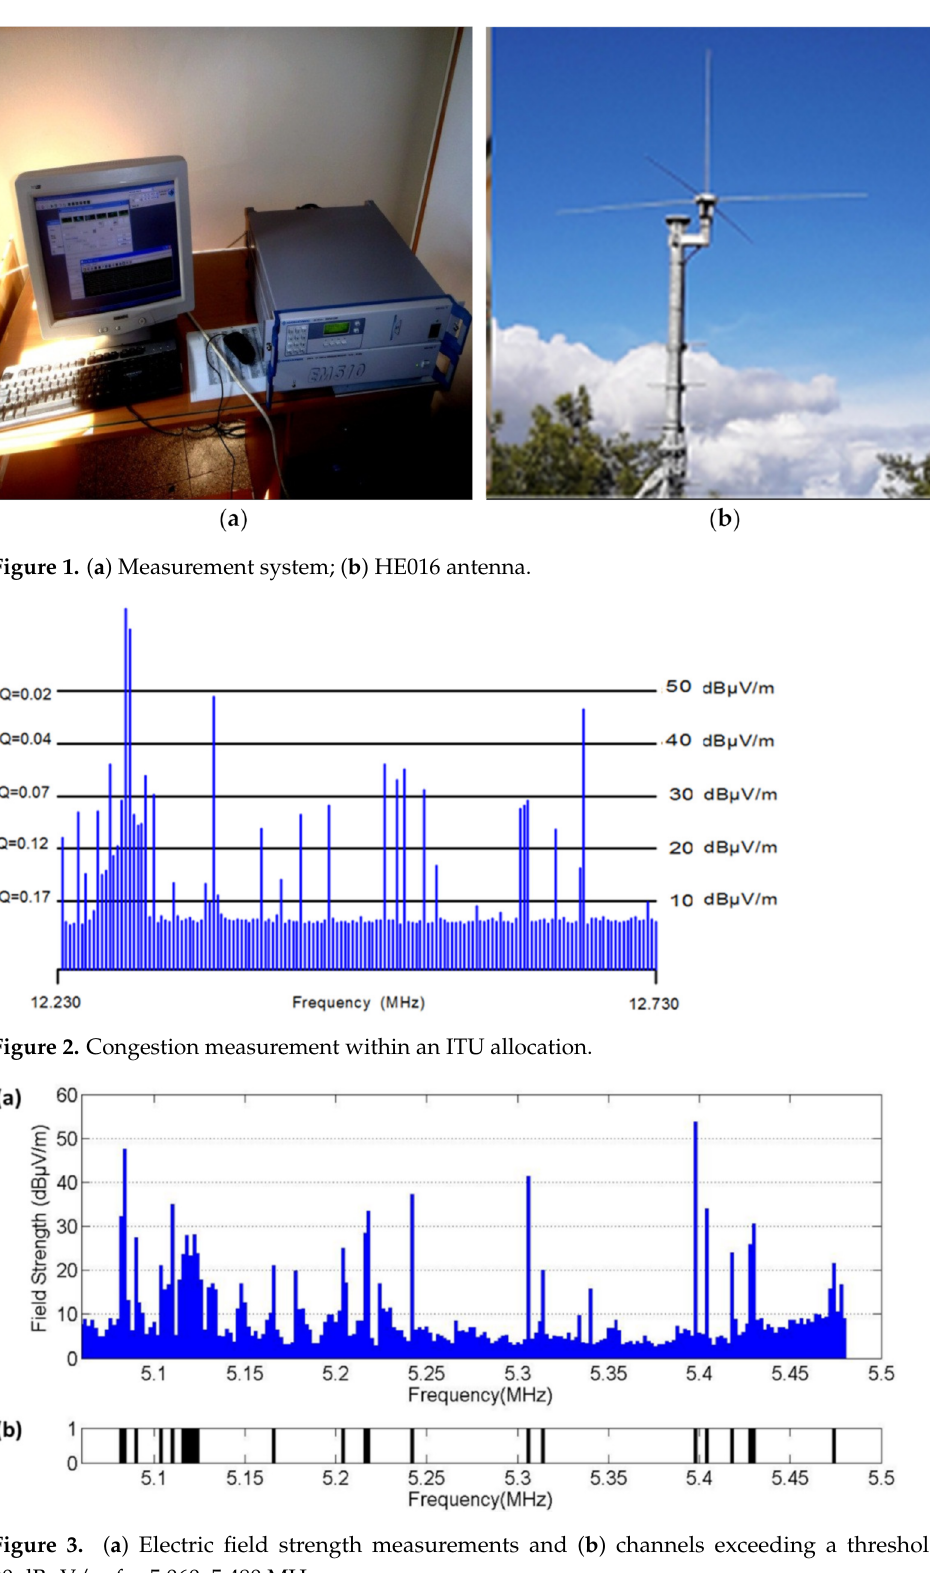
Figure 3. ( a ) Electric field strength measurements and ( b ) channels exceeding a threshold of 20 dB µ V/m for 5.060–5.480